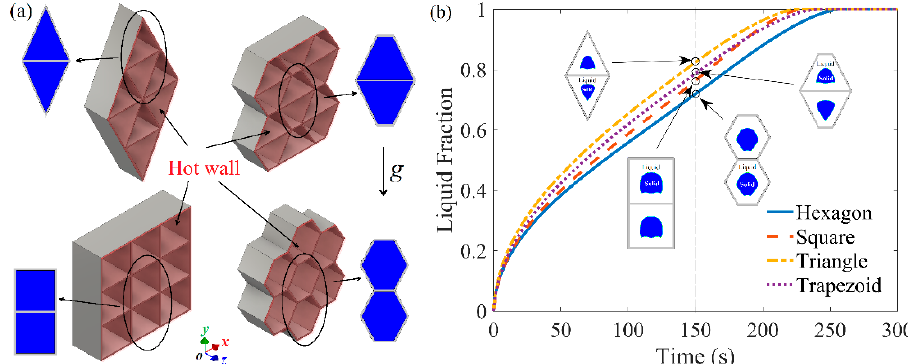
Figure 4. ( a ) Sketch of 2D cross-sections of triangular, trapezoidal, square, and hexagonal cells